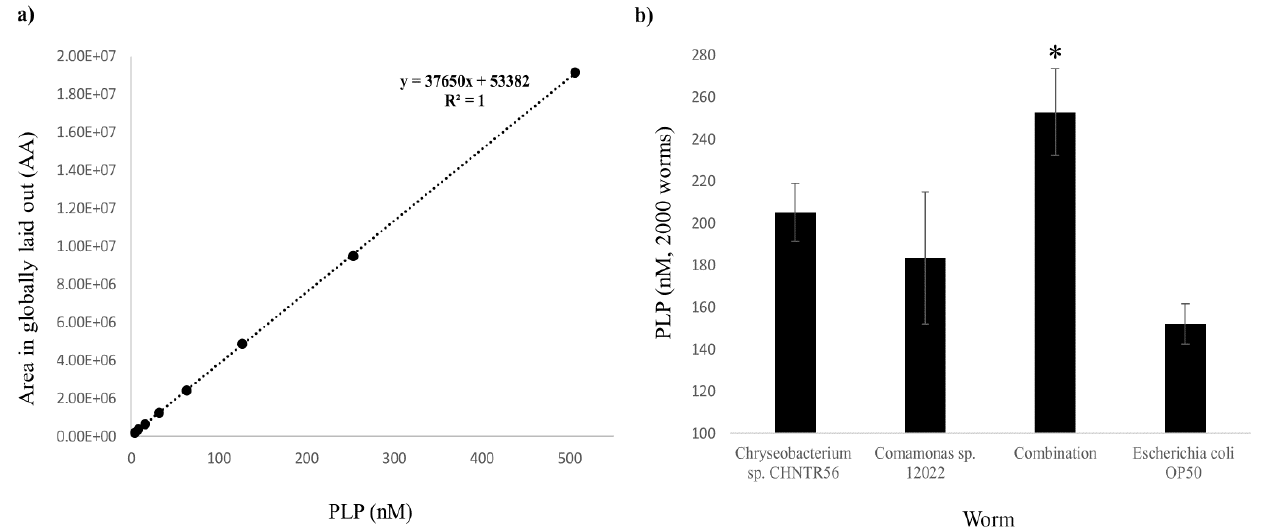
Figure 2. Abundance of PLP (nM) in worms grown with bacterial isolates. ( a ) Linear curve of standard PLP with R 2 score is shown; ( b ) The abundance of PLP (from 2000 worms) was significantly higher in worms grown with the combination of bacterial isolates, while it was similar among worms grown with the isolates individually or E. coli OP50. *: p < 0.05.